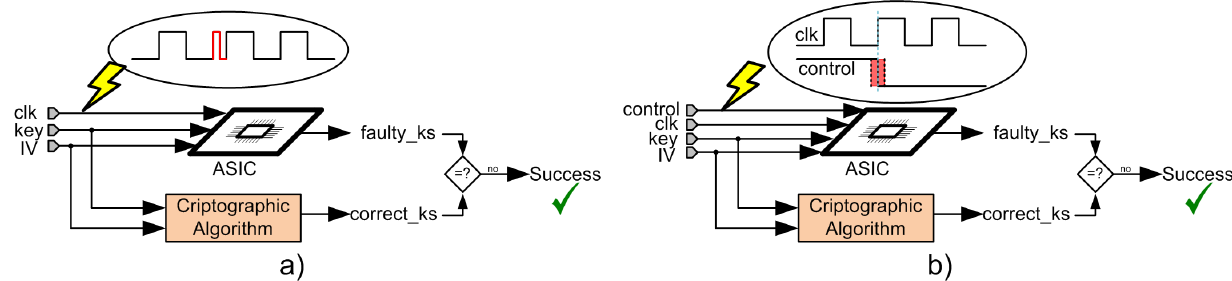
Figure 11. Schematic representation of the implemented attacks. ( a ) attack process manipulating the clock signal; ( b ) attack process manipulating the control signals.